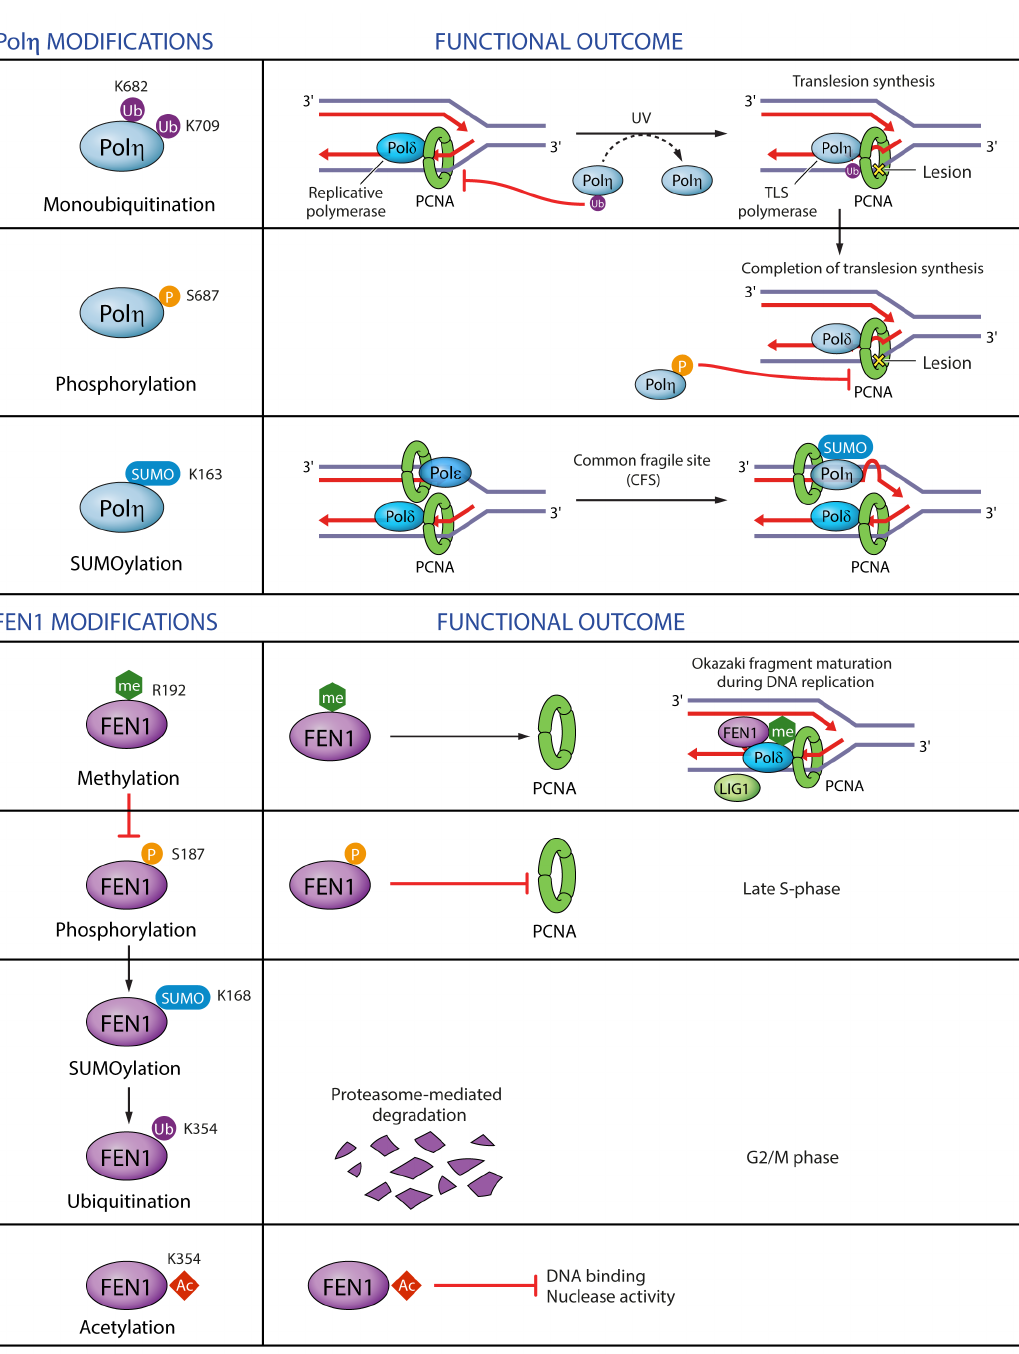
Figure 9. Regulation of PCNA-interacting proteins by post-translational modifications. Examples are given for two PCNA-interacting proteins: Pol η and FEN1. Monoubiquitination of Pol η suppresses monoubiquitinated PCNA and Pol η -mediated translesion synthesis. Pol η phosphorylation weakens its binding to PCNA and may promote its dissociation from replication forks upon completion of translesion synthesis. Pol η SUMOylation promotes Pol η recruitment to difficult-to-replicate common fragile sites. FEN1 methylation promotes its interaction with PCNA during Okazaki fragment maturation. FEN1 methylation antagonizes its phosphorylation, which abrogates its binding to PCNA. FEN1 phosphorylation promotes its SUMOylation and ubiquitination leading to FEN1 proteasome-mediated degradation in G2/M phase of the cell cycle. FEN1 acetylation negatively regulates its binding to DNA and its nuclease